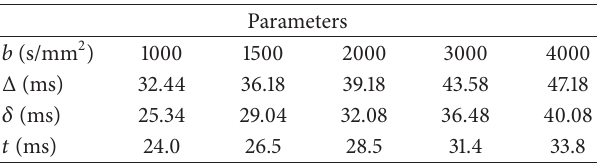
Table 2: Parameters for the synthetic data similar to the one from our real data